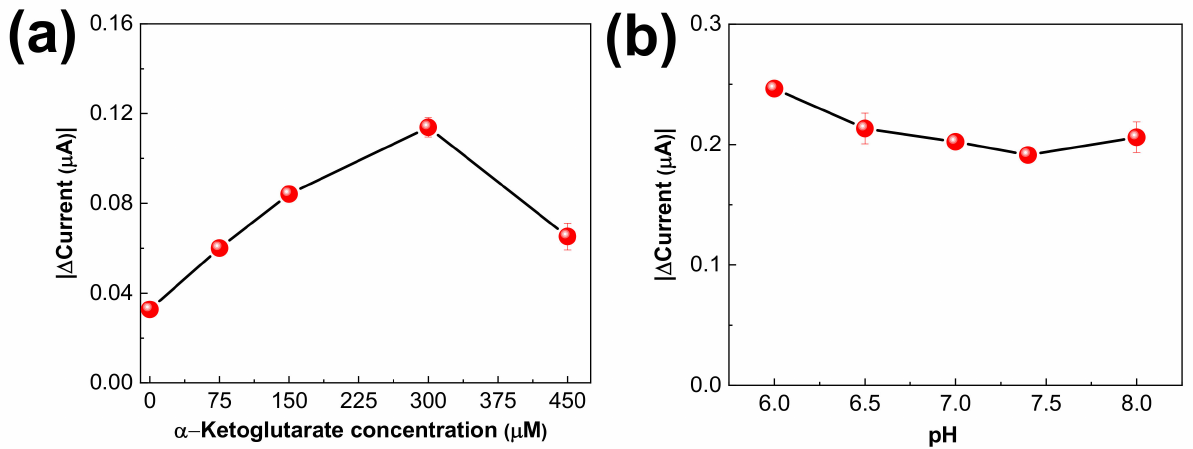
Figure 4. ( a ) Current changes against 0.8 mM Asp using GluOx–ASTENs/PB/SPCE fabricated using 25 U/mL GluOx and 62.5 U/mL AST in the presence of different concentrations of α -ketoglutarate (i.e., 0.0, 75.0, 150 and 300 µ M) in the buffer. ( b ) Current changes across varied pH solutions on GluOx–ASTENs/PB/SPCE in 0.8 mM Asp in buffer at the applied potential of − 0.1